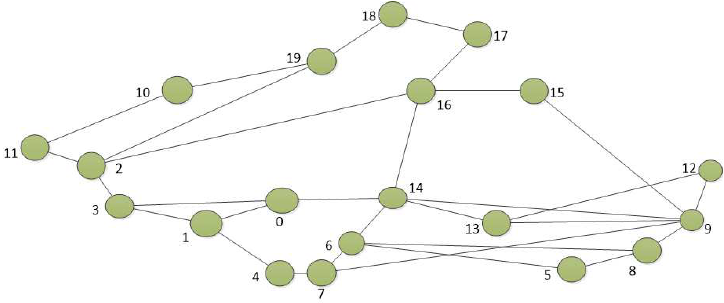
Figure 2. Elibackbone topology. The network consists of 20 nodes and 30